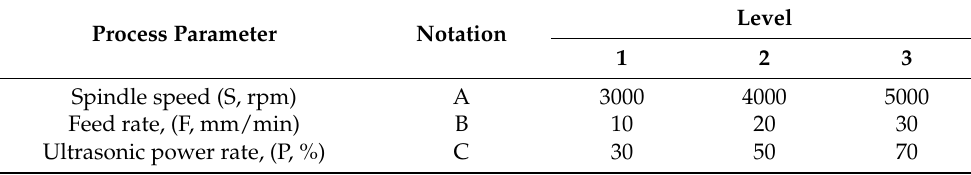
Table 1. Experiment parameters and their